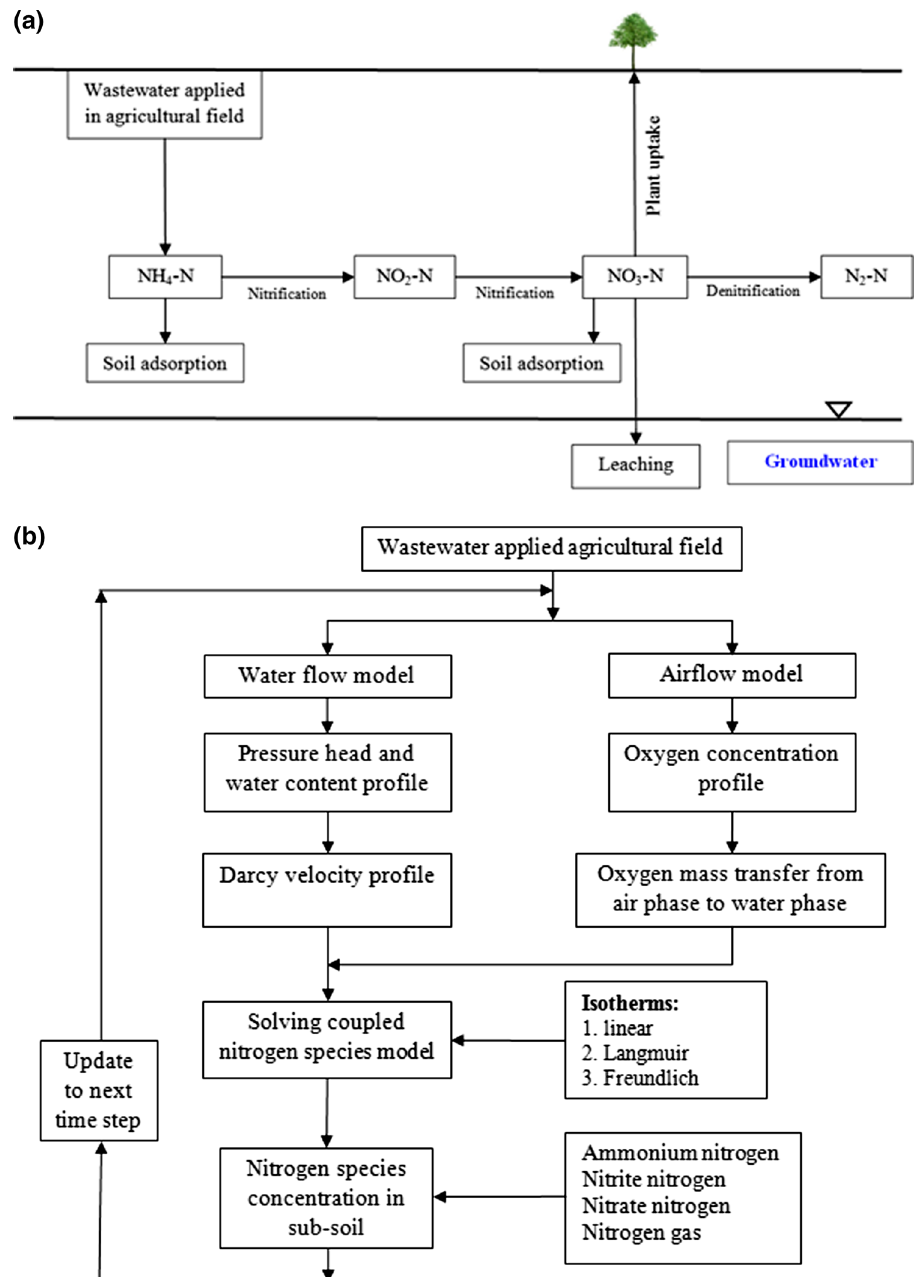
Fig. 1 a Conceptual model for nitrogen cycle in subsurface system (Berlin et al. 2013). b Procedure to solve the coupled water flow, air flow and trans- port of nitrogen species, DOC and DO models in unsaturated porous